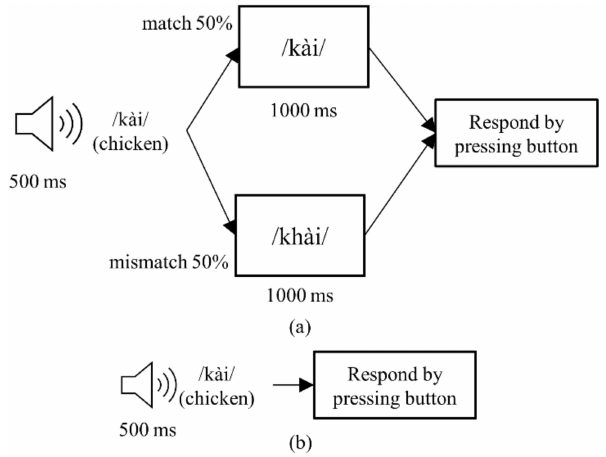
Figure 2. Event sequence for each trial in ( a ) Method 2; ( b ) Method